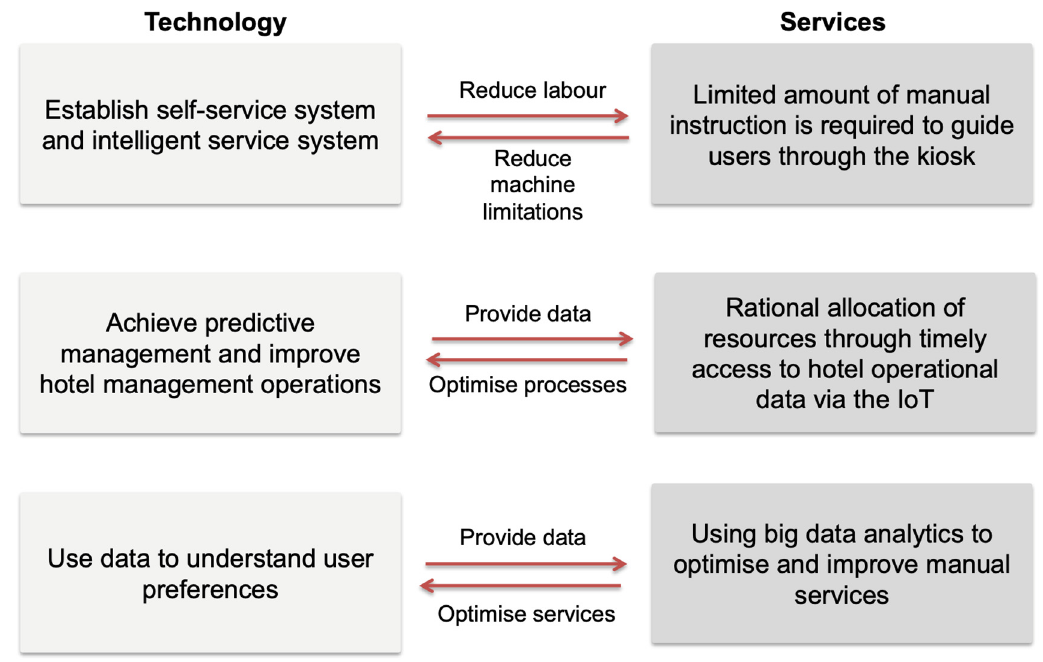
Figure 13. The integration of the Internet of Things in hotels with services.